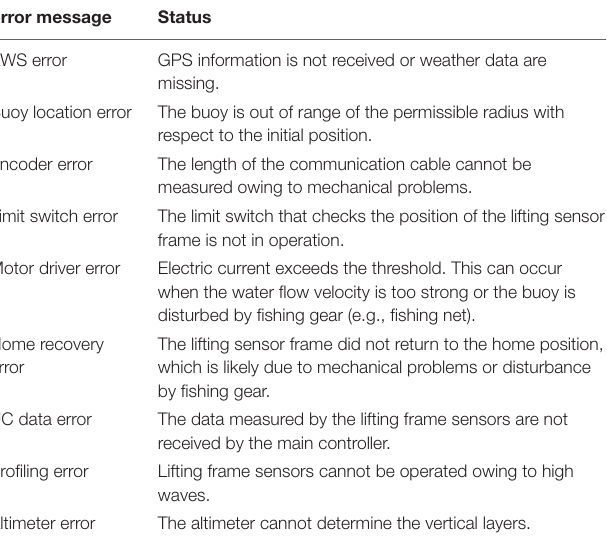
TABLE 3 | Error messages and status updates sent from INBUS-2.